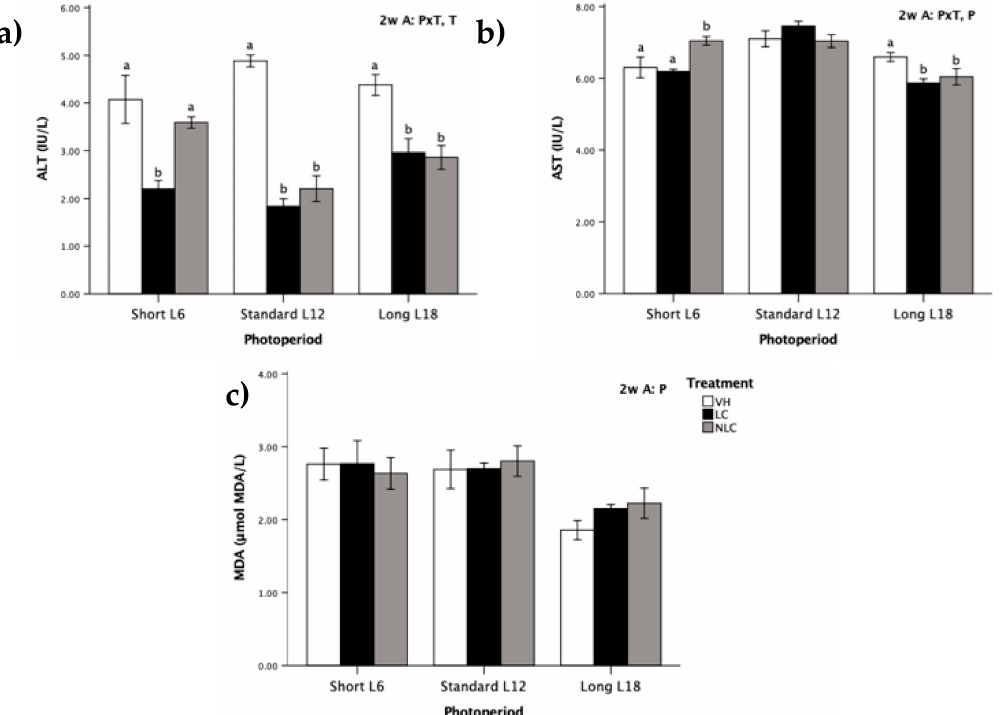
Figure 2. Serum oxidative stress biomarkers in Fischer 344 rats exposed to three photoperiods for 7 weeks and supplemented with local sweet cherry (LC), non-local sweet cherry (NLC), or vehicle (VH): ( a ) alanine aminotransferase (ALT) activity; ( b ) aspartate aminotransferase (AST) activity; ( c ) malondialdehyde (MDA) level. Data are expressed as the mean ± SEM ( n = 8). Two-way ANOVA was used to evaluate the di ff erences between the groups, thus we could determine the e ff ects of the photoperiod, P; the treatment, T; or the photoperiod × treatment interaction, P × T. Later on, one-way ANOVA was used to evaluate significant di ff erences among the treatments (LC, NLC, and VH) within each photoperiod exposure (Short L6, Standard L12, and Long 18); these di ff erences are indicated with di ff erent letters. Abbreviations: L6: 6 h light / day, L12: 12 h light / day, L18: 18 h light / day, SEM: standard error of the mean, ANOVA: analysis of variance.